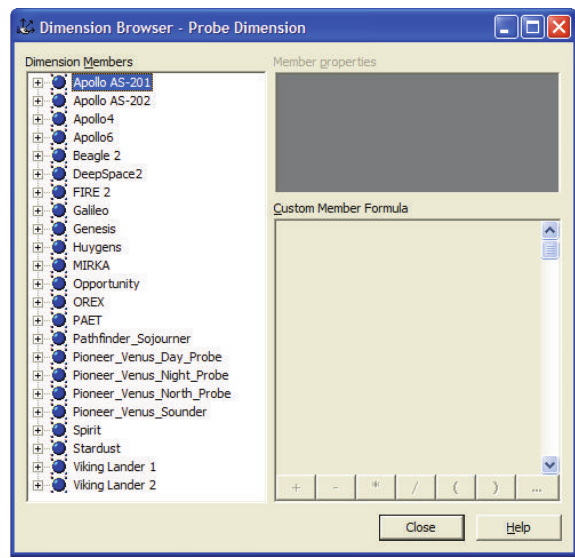
Figure 6: Planetary probes modeled in OLAP DB.